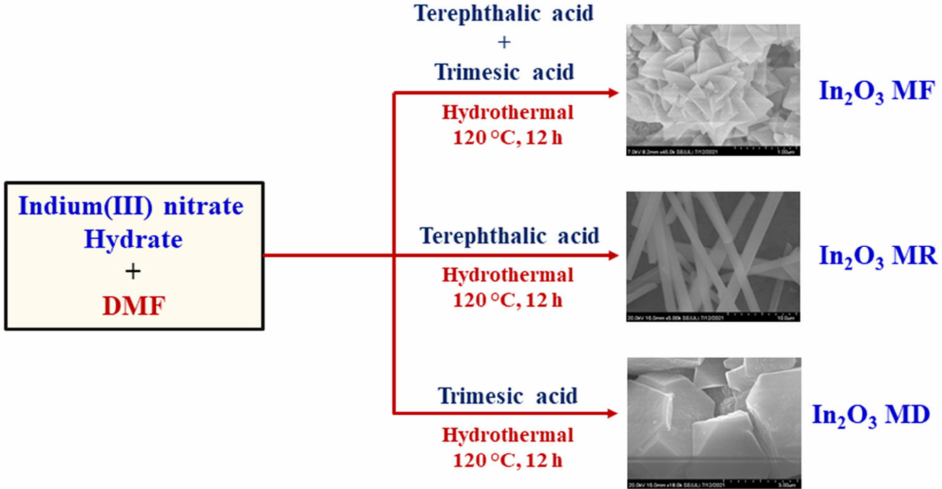
Figure 1. Schematic illustration of the synthesis of the In 2 O 3 -MF, In 2 O 3 -MR, and In 2 O 3 -MD via a hydrothermal